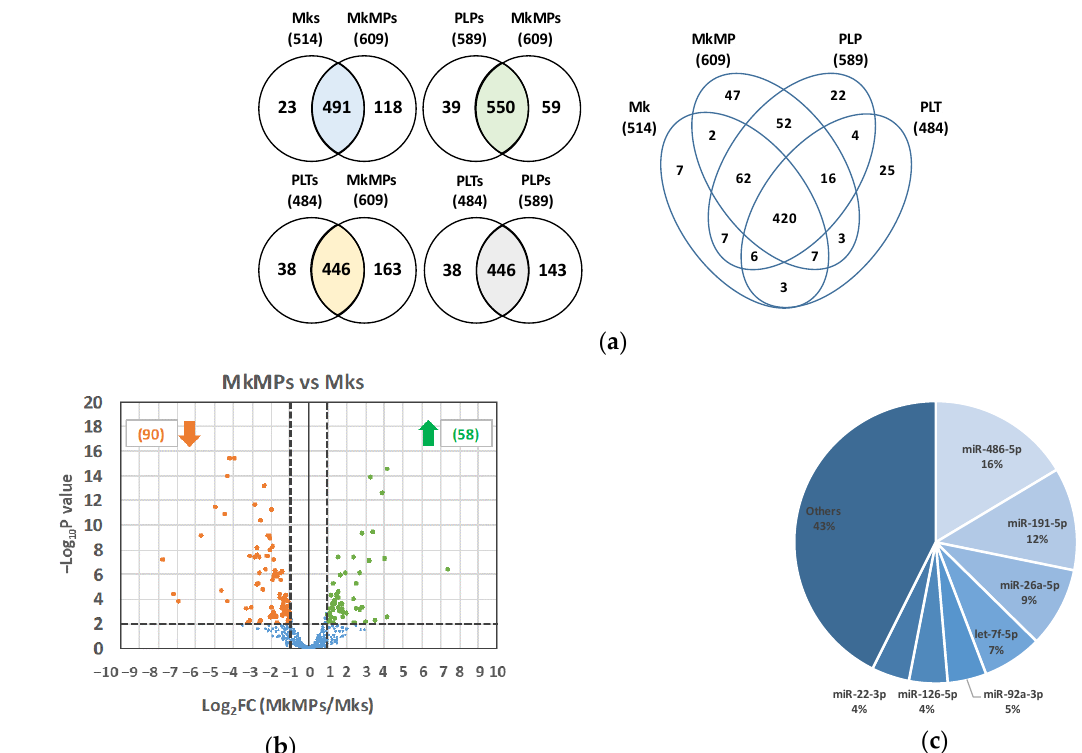
Figure 1. RNAseq analysis of miRs ( a ) Venn diagram showing the number of miRs detected in (CPM ≥ 1) and shared among Mks, MkMPs, PLPs, and PLTs. ( b ) Volcano plot showing the results from the differential expression analysis of miRs in MkMPs vs. Mk cells. A total of 58 miRs were significantly ( p < 0.01) enriched (fold change ≥ 2) in MkMPs, while expression levels of 90 MkMP miRs were significantly lower (fold changes ≤ 0.5) than in Mk cells. ( c ) Pie chart showing the miR distribution in MkMPs. The top seven (7) miRs are shown in detail.